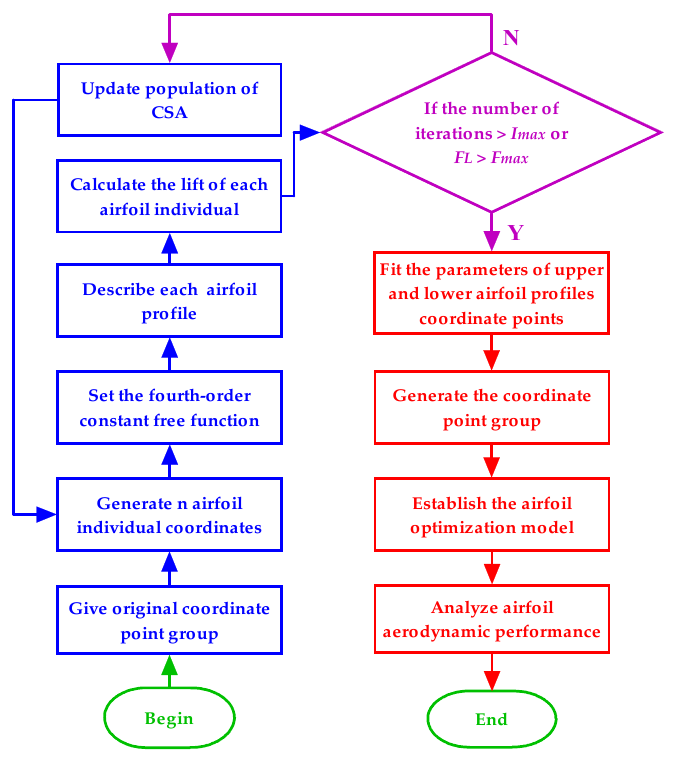
Figure 1. Flow chart of CSA-KJ airfoil optimization method.